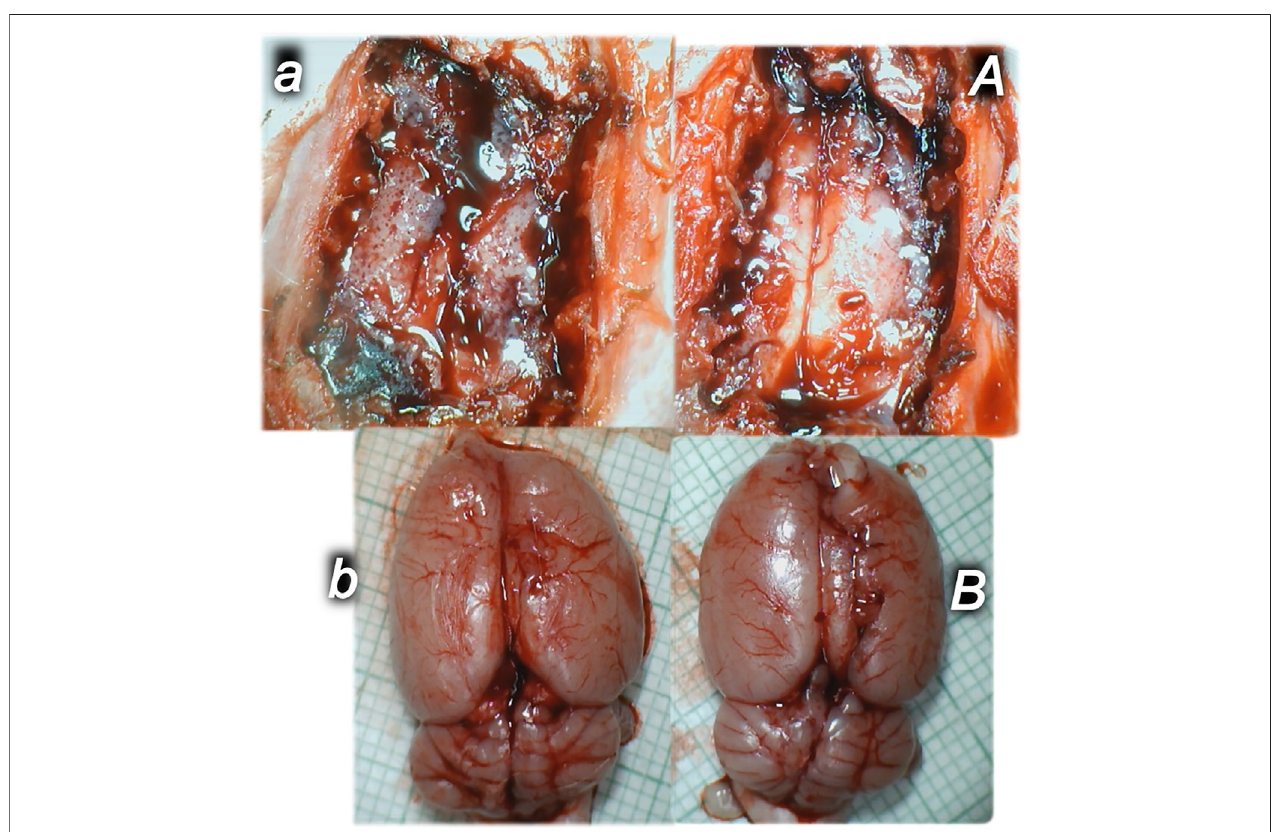
FIGURE 5 | Illustrative brain presentation in the rats with the increased intra-abdominal pressure (50 mm Hg). In calvarial window (upper) , at 15 min increased pressuretimeandmedicationsaline(5 ml/kgip) (upper,left,control, a ) orBPC157(10 ng/kgsc) (upper,right, A ) ,at10 minincreasedintra-abdominalpressuretime. After sacri fi ce (low) , at the 25 min increased intra-abdominalpressuretime(saline(5 ml/kg ip) (low,left, control, b ) or BPC157(10 ng/kg sc) (low, right, B ) at 10 min increased intra-abdominal pressure time. Prominent brain swelling in control rats (left) , completely reversed in BPC 157 rats (right) . A camera attached to a VMS- 004 Discovery Deluxe USB microscope (Veho, United